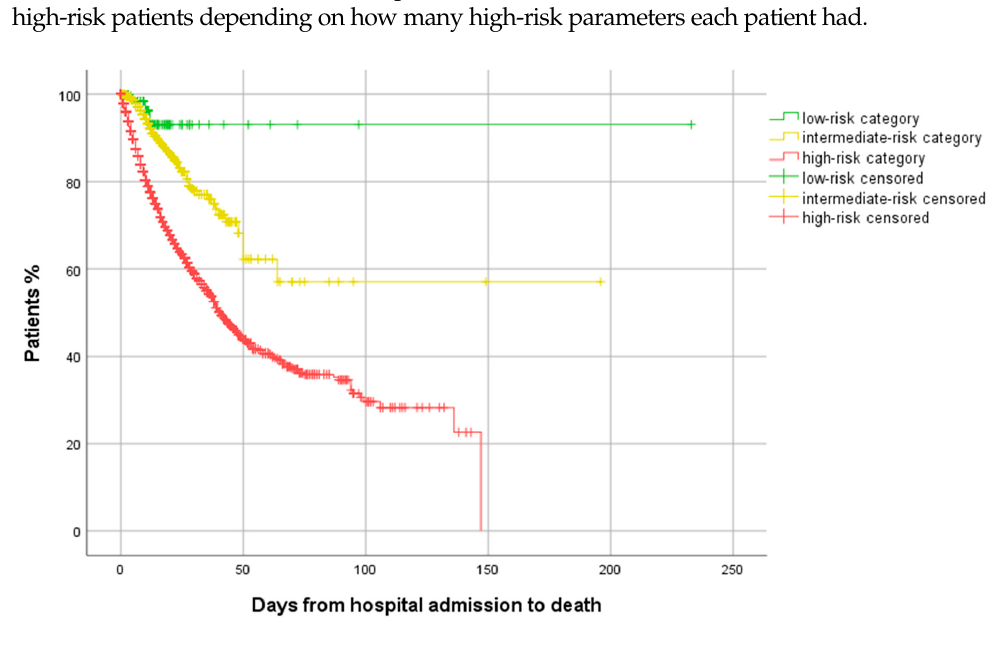
Figure 1. Time to death for the three categories (Log rank 325.6 p < 0.001).